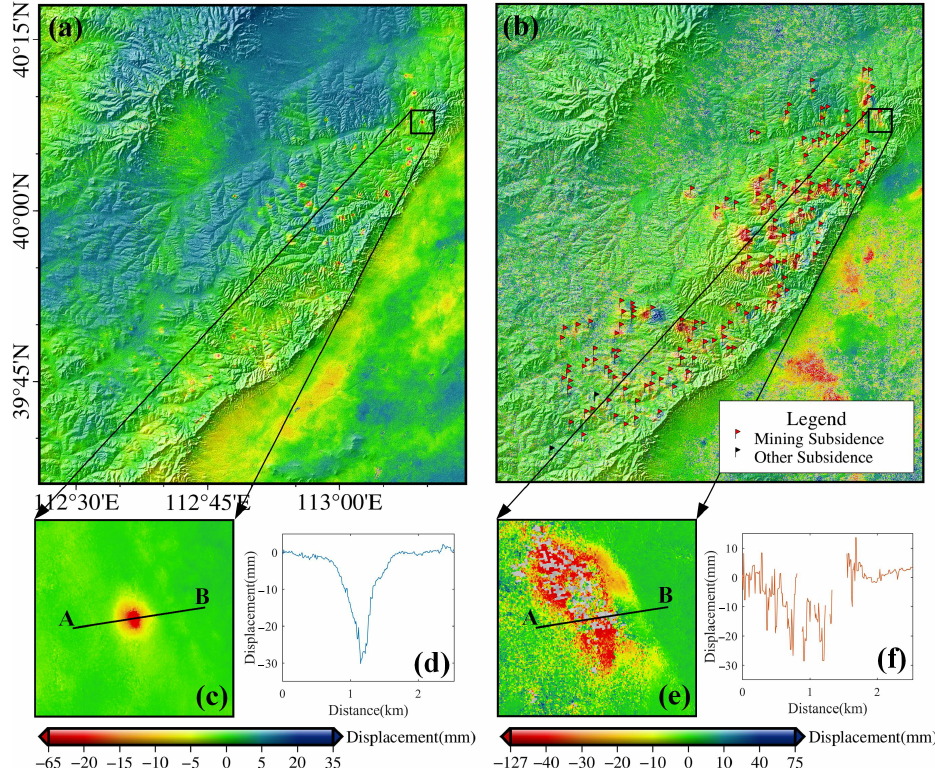
Figure 4. The displacement results from DInSAR monitoring: ( a , b ) are the DInSAR monitoring results under short-term baseline and long-term baseline, respectively, ( c , e ) are enlarged views, ( d , f ) are the deformation displacement line diagrams of section line AB in ( c , e ).